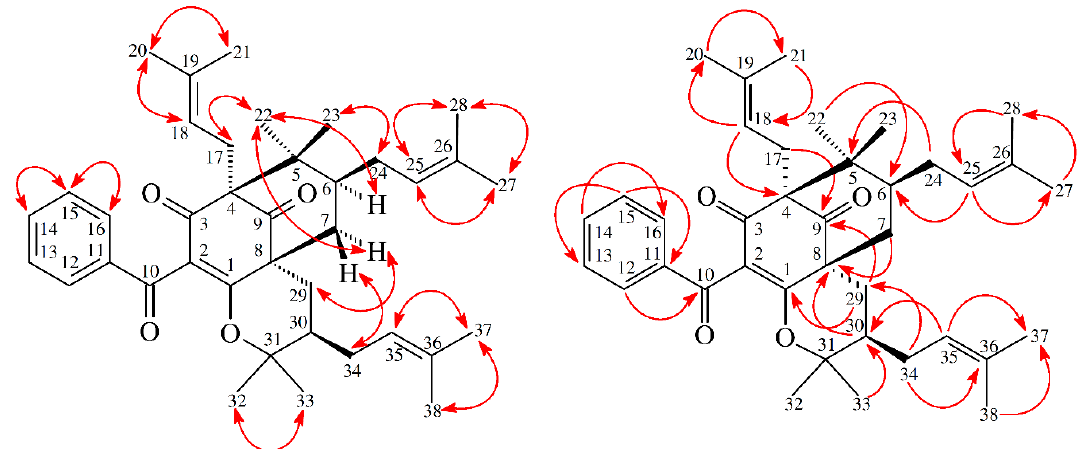
Figure 3. Key NOESY ( ) and HMBC ( ) correlations of 1 . Figure 6. Key NOESY ( ) and HMBC ( ) correlations of 2 . ) and HMBC ( Figure 6. Key NOESY ( ) and HMBC ( ) correlations of 2 . Figure 6. Key NOESY ( Figure 6. Key NOESY ( ) and HMBC ( ) correlations of 2 .